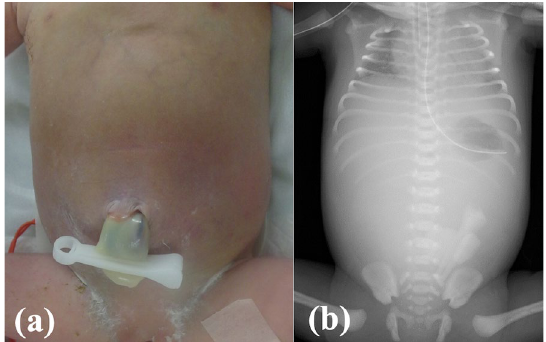
Fig. 2 General appearance and the X-ray at birth: a newborn’s abdomen was dark and severely distended. b X-ray shows gasless